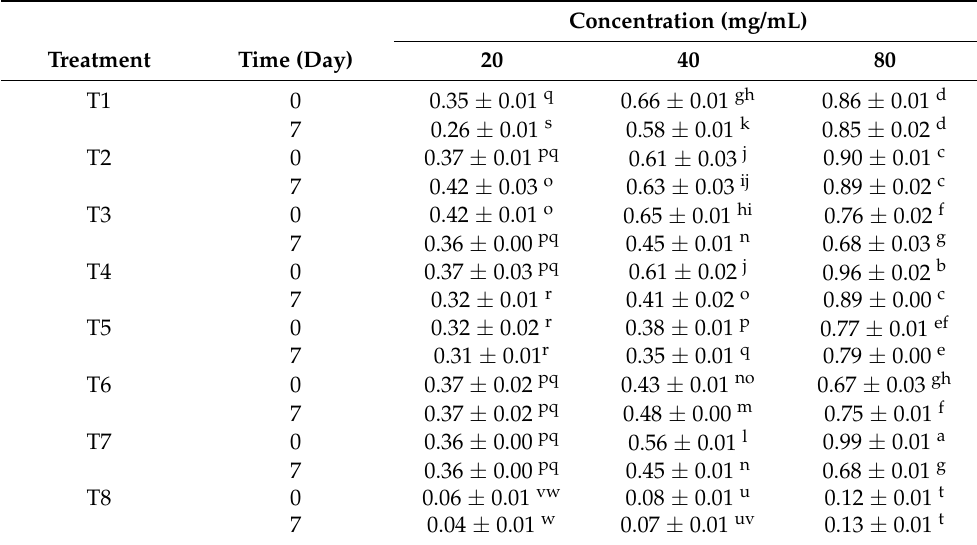
Table 5. Total antioxidant activity of crude peptide extracts from fermented milk samples obtained just after fermentation (day 0) and after 7 days of